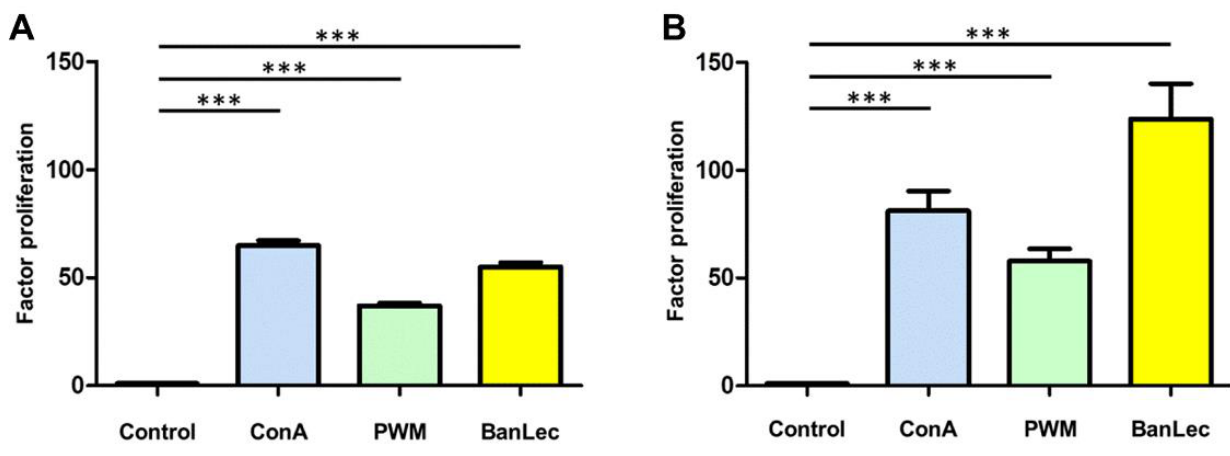
Figure 1. PBMC of 148 dairy cows ( A ) and 36 pigs ( B ) showed a significantly higher proliferation rate (*** p < 0.001, paired t -test) after polyclonal in vitro stimulation with ConA (blue bar), PWM (green bar) and BanLec (yellow bar).